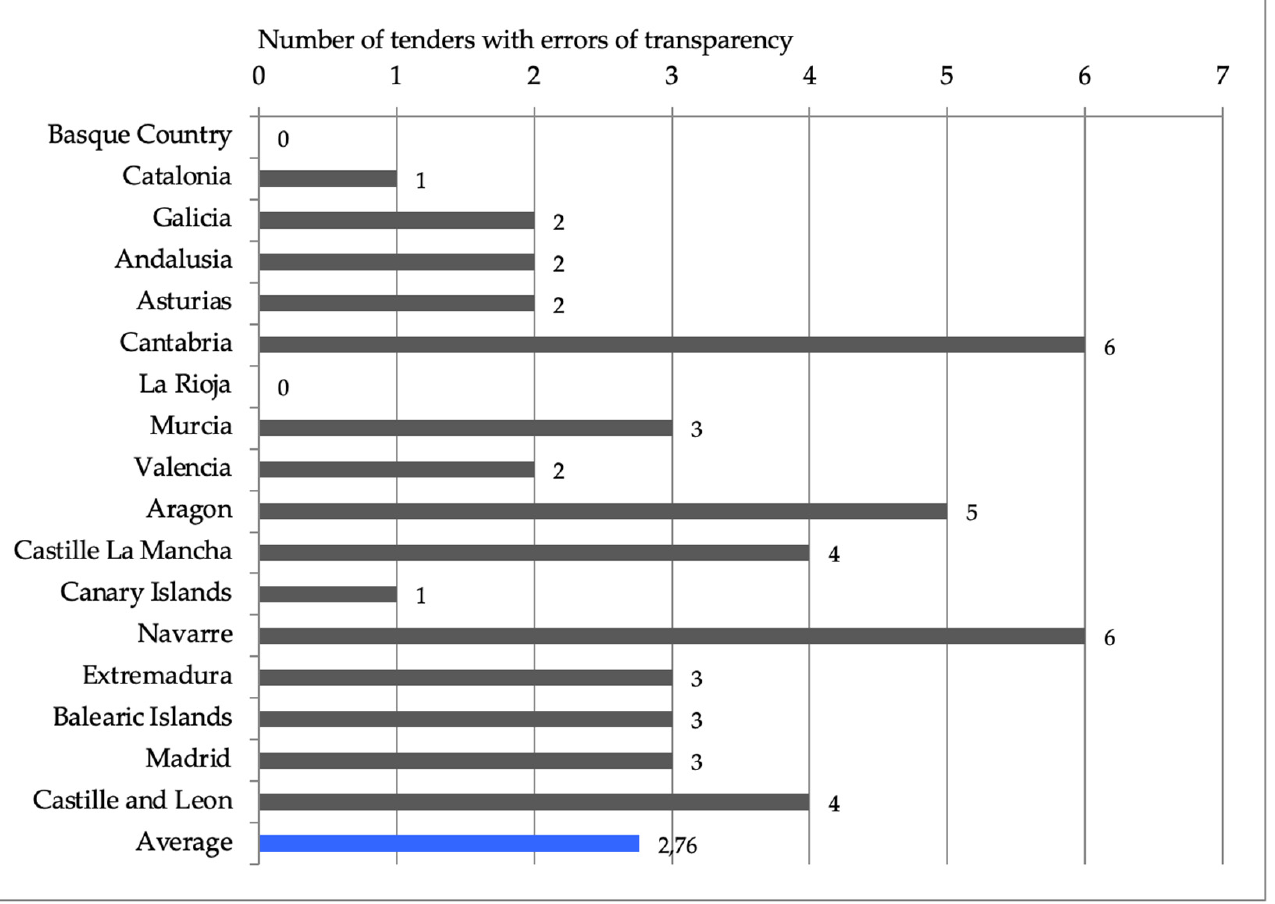
Figure 1. Analysed tenders with weak regulatory compliance.